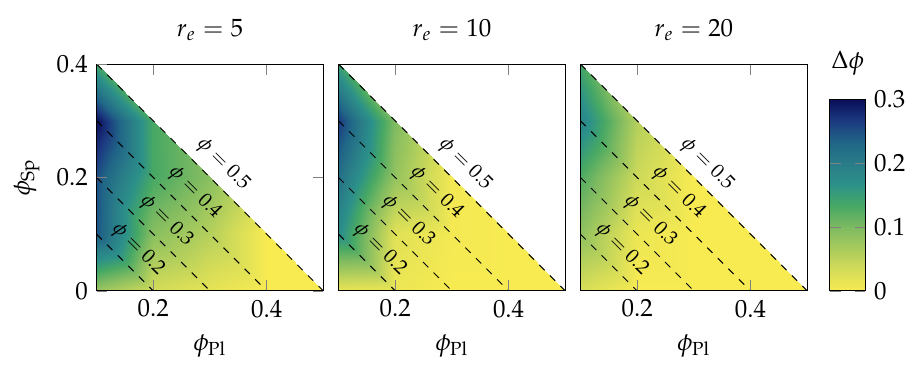
Figure 9. Increase in filling fraction ∆ φ for various paste